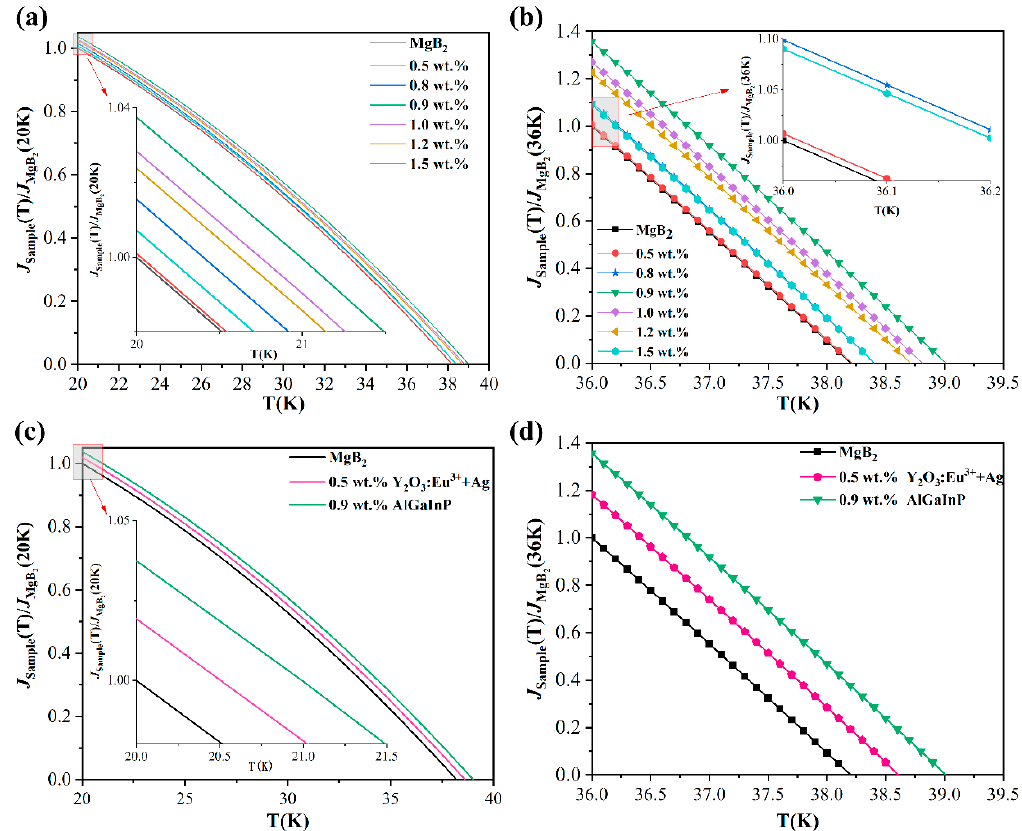
Figure 6. Relationship between J C and temperature T of MgB 2 samples. ( a , b ) Pure MgB 2 and inhomogeneous phase samples. ( c , d ) Comparison of J C for the maximum variation of T C produced by pure MgB 2 and oxide luminescent inhomogeneous phase [46], p-n junction inhomogeneous phase.